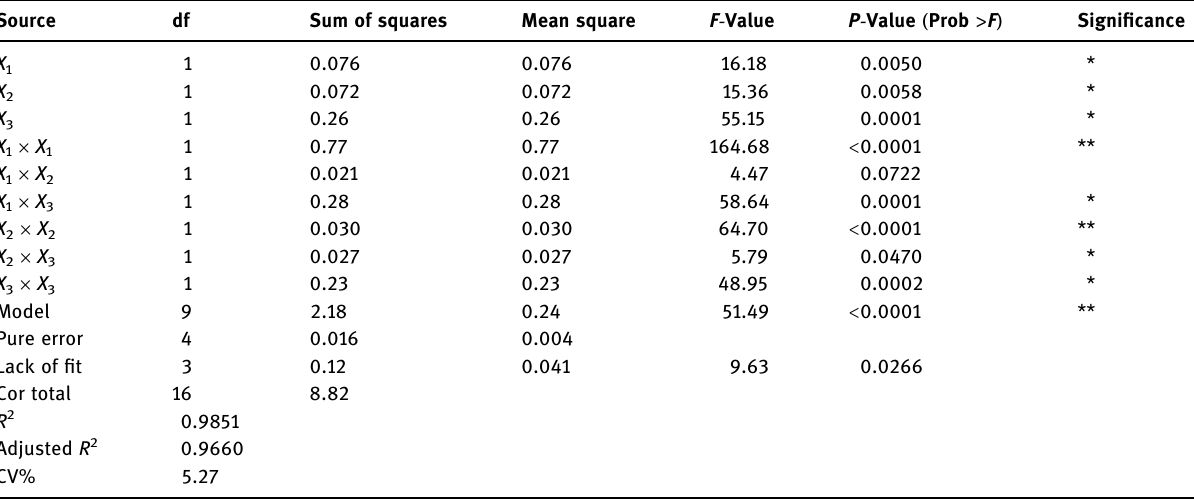
Table 6: Standard analysis of variance for the Box – Behknen experimental results Source df Sum of